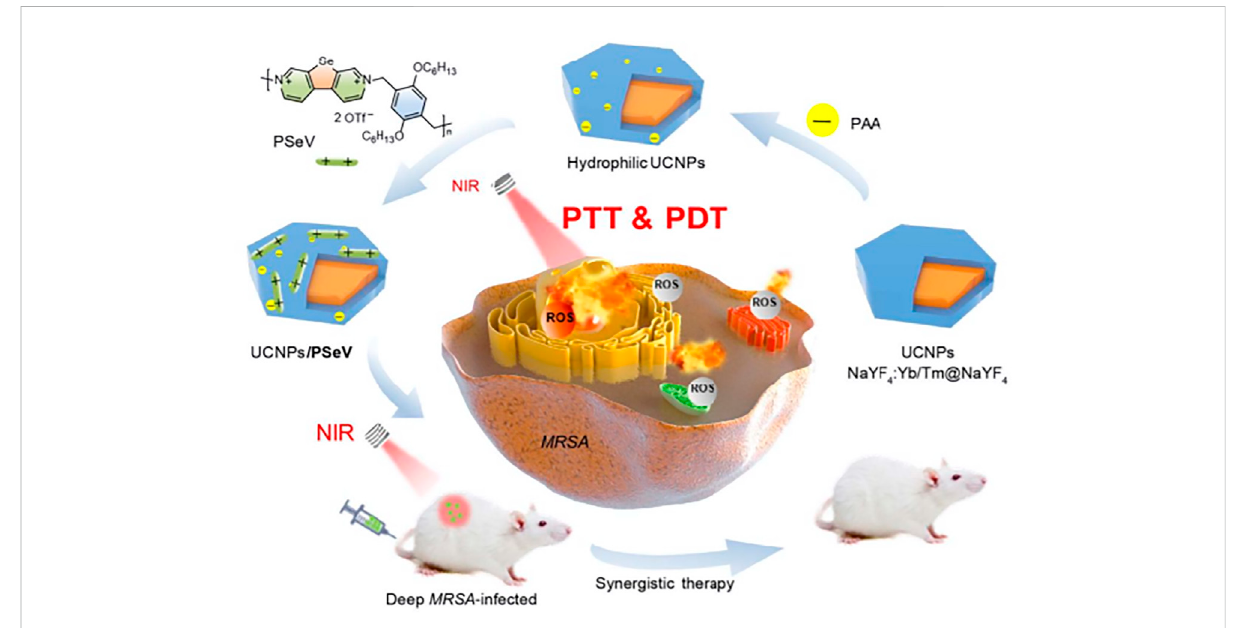
FIGURE 4 The PAA surface-modi fi ed UCNPs were assembled with PSeV to formulate a PTT and PDT synergistic conjugates. Photothermal and photodynamic effects combined to kill MRSA in deep tissue with NIR light (Zhou et al.,